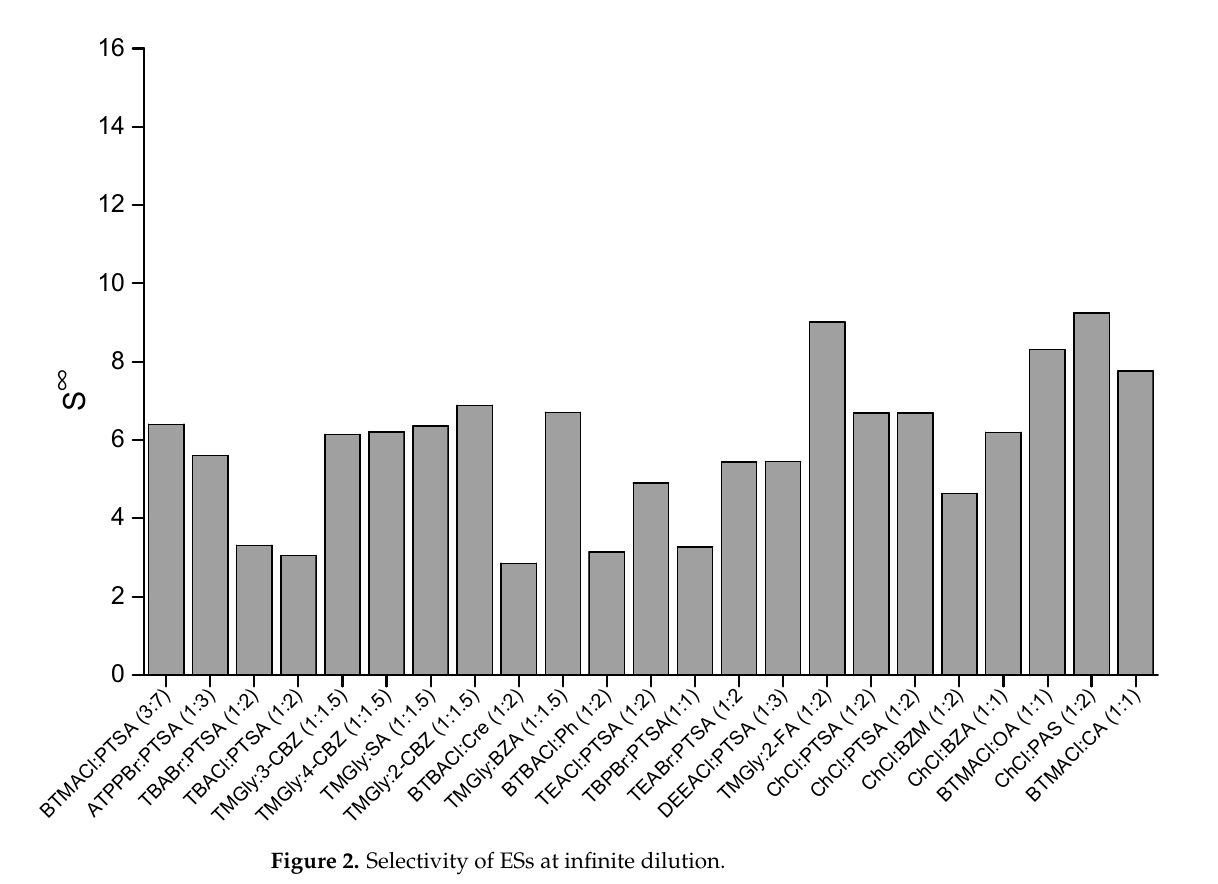
Figure 2. Selectivity of ESs at infinite dilution.